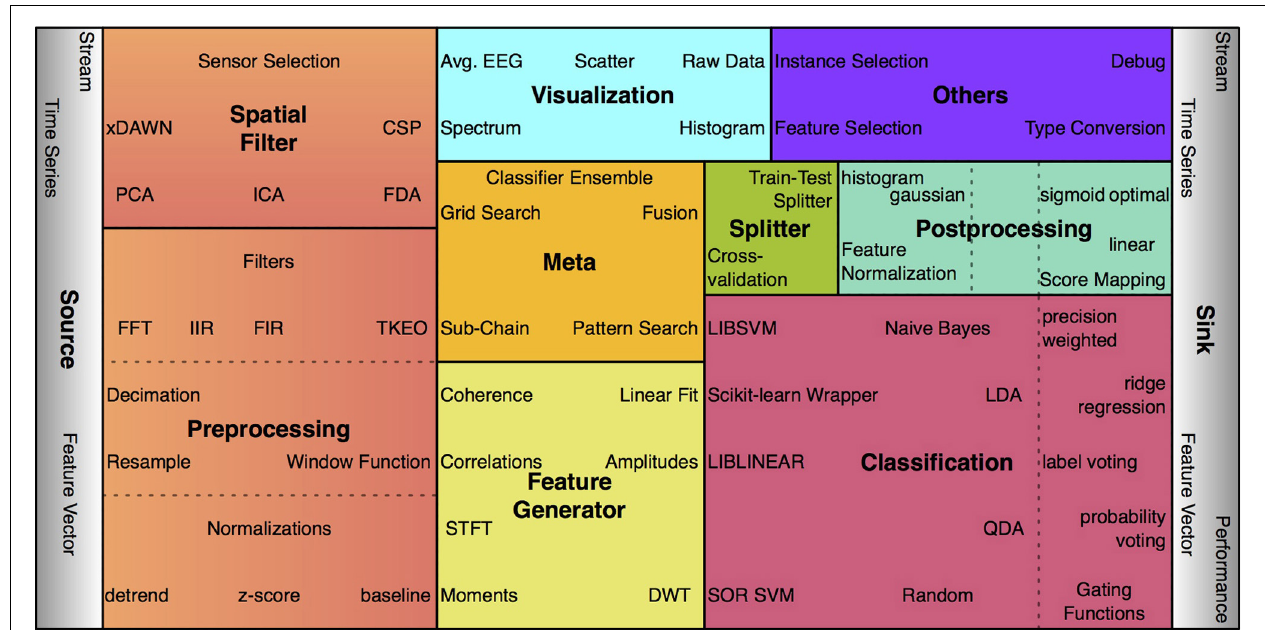
FIGURE 2 | Some examples of the more than 100 processing nodes in pySPACE, arranged according to processing categories (package names). The size of the boxes indicates the respective number of currently available algorithms. For classification, postprocessing and preprocessing, subcategories are